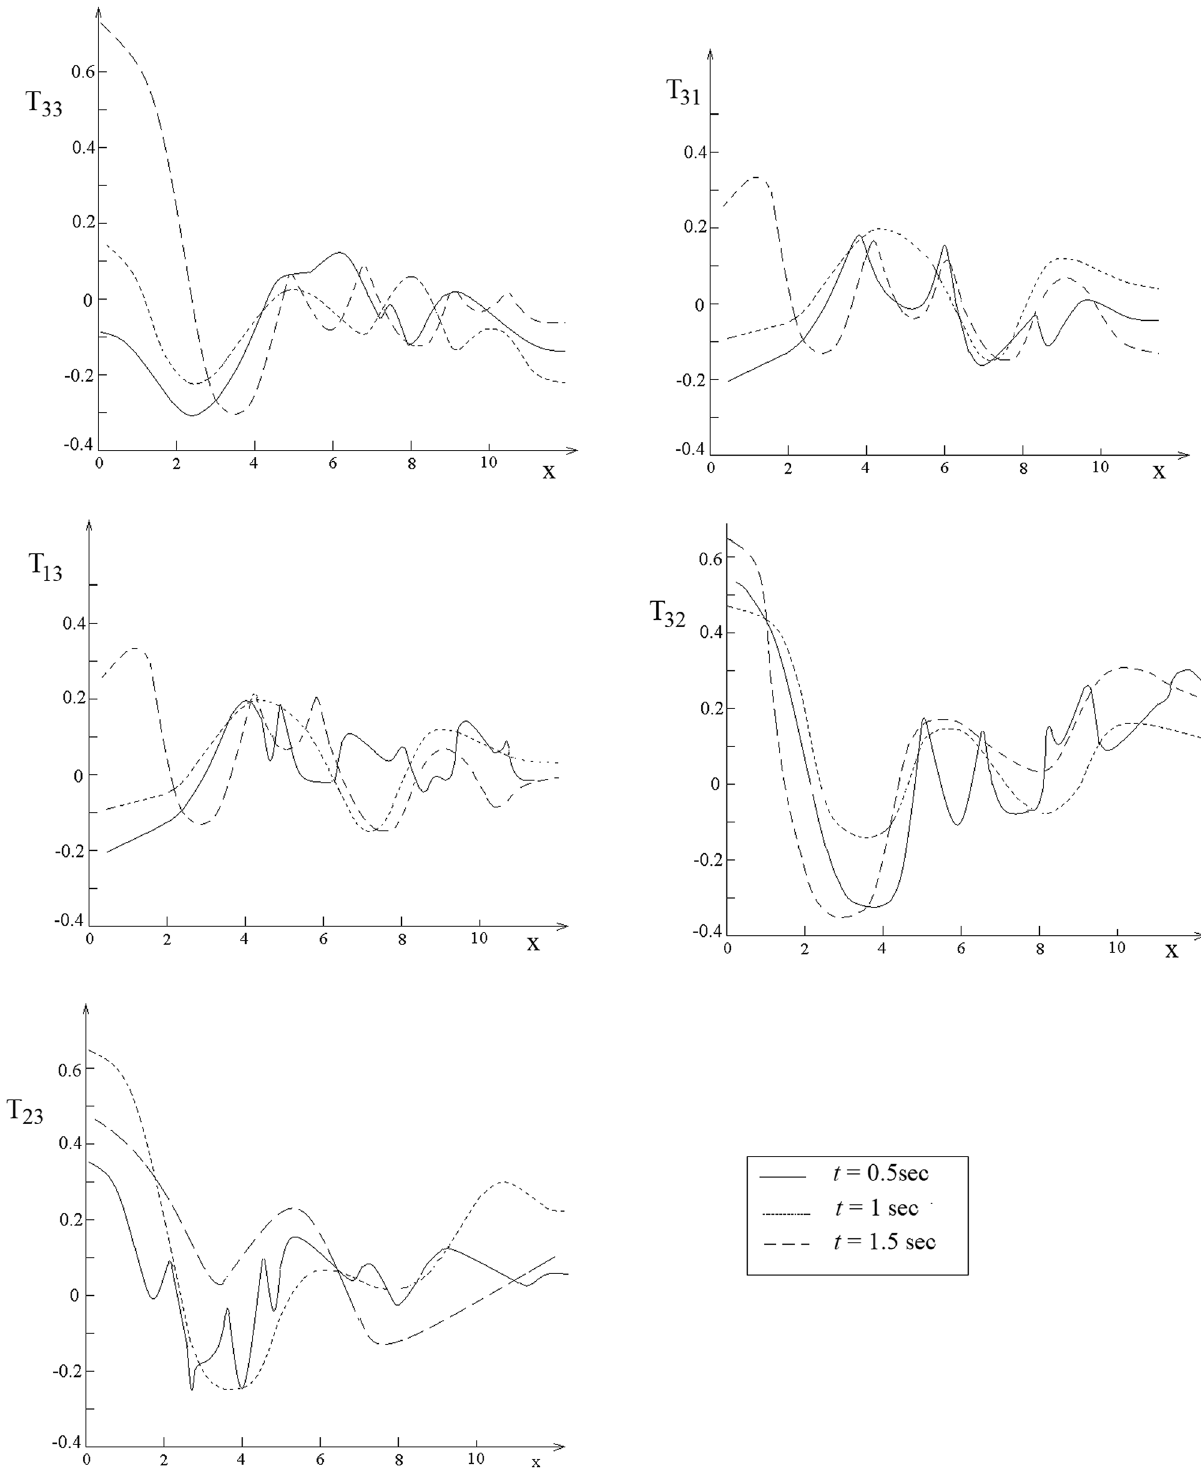
Figure 11. Plots of T 13 , T 23 and T 33 with respect to x